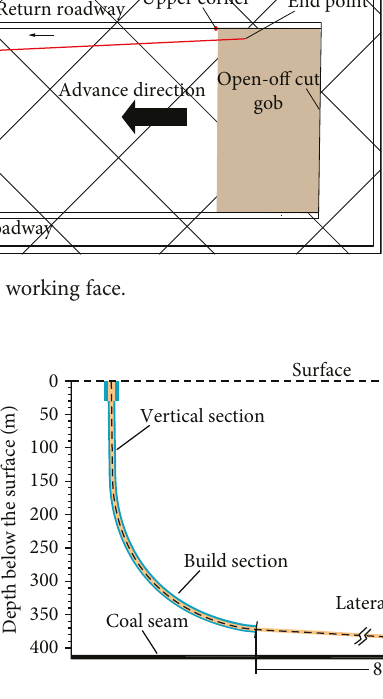
Figure 4: Trajectory of the